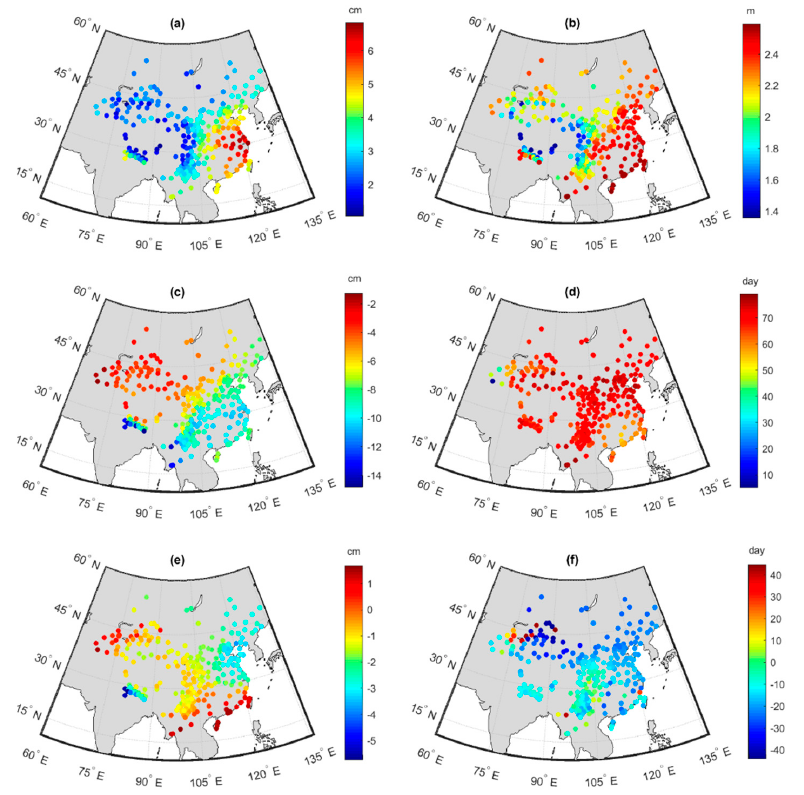
Figure 2. Parameters of the empirical temporal zenith tropospheric delay (ZTD) variations model of each site. ( a ) fitting root mean square (RMS); ( b ) the constant term A 0 ; ( c ) annual amplitude A 1 ; ( d ) initial phase of annual term d 1 ; ( e ) semi-annual amplitude A 2 ; ( f ) initial phase of semi-annual term d 2 . It should be noted that the amplitudes are modified to make the phase terms continuous and in the range of (0, 90) and ( − 45, 45) for the annual and semi-annual terms,